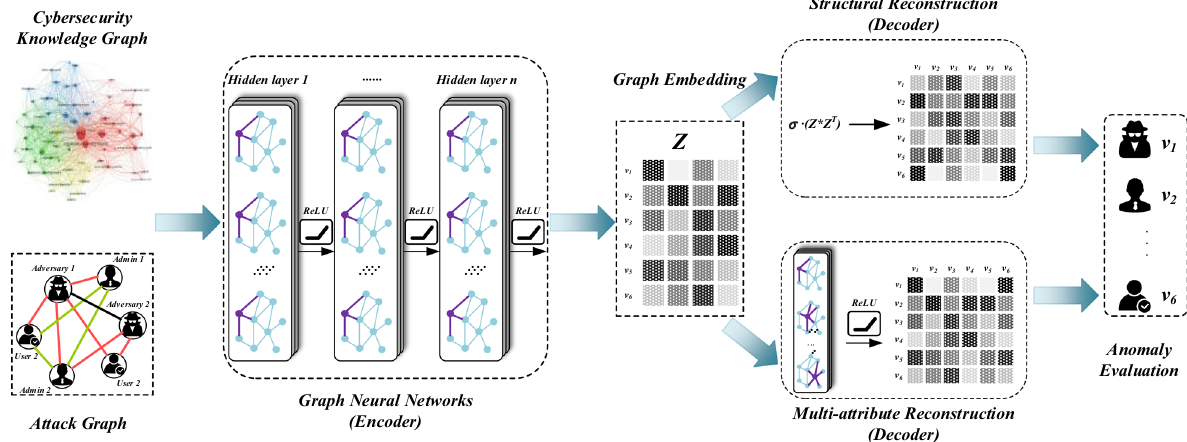
Figure 8. This paper propose an anomaly detection scheme based on the cybersecurity knowledge graph. The framework mainly includes three parts: construction of graph model, graph embedding, and anomaly evaluation. First, taking the cybersecurity knowledge graph and attack graph as input, the graph neural networks (encoder) embedding the graph’s vertices to obtain the attack graph’s characteristic representation. Then add structural anomaly features and attribute anomaly features, graph neural networks (decoder) learn the threat degree of each node to other nodes, and aggregate the node’s threat degree. After many iterations, the model finally gets each node’s anomaly ranking in the cybersecurity knowledge